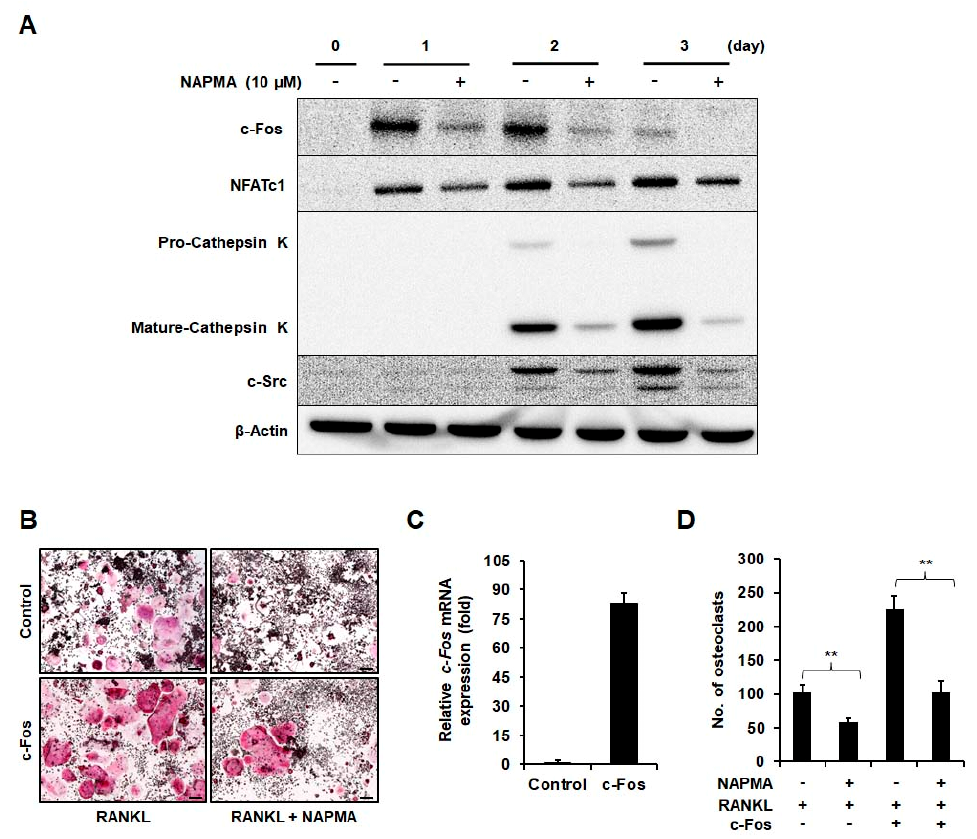
Figure 3. NAPMA suppresses the expression of c-Fos, NFATc1, cathepsin K, and c-Src. ( A ) NAPMA inhibits the RANKL-induced expression of c-Fos, NFATc1, cathepsin K, and c-Src proteins. BMMs were treated with or without NAPMA (10 µ M) in the presence of RANKL (50 ng / mL) and M-CSF (30 ng / mL). Protein expression was examined using western blotting after the indicated treatment times. ( B ) RAW264.7 cells were transfected with empty vector (Control) or c-Fos vector (c-Fos) and then incubated with or without NAPMA (10 µ M) in the presence of RANKL (50 ng / mL). The data presented are the mean ± SD of four independent experiments. Scale bar = 200 µ m. After three days, the cell was fixed and stained for the TRAP assay. ( C ) The expression of c-Fos was analyzed by real-time PCR in empty vector- and c-Fos vector-transfected RAW264.7 cells. ( D ) TRAP-positive multinucleated osteoclasts ( ≥ 3 nuclei) were counted. The data are presented as the mean ± SD of three independent experiments. ** p <